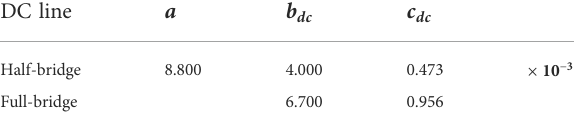
TABLE 1 Converter loss coef fi cients (in P.U.).